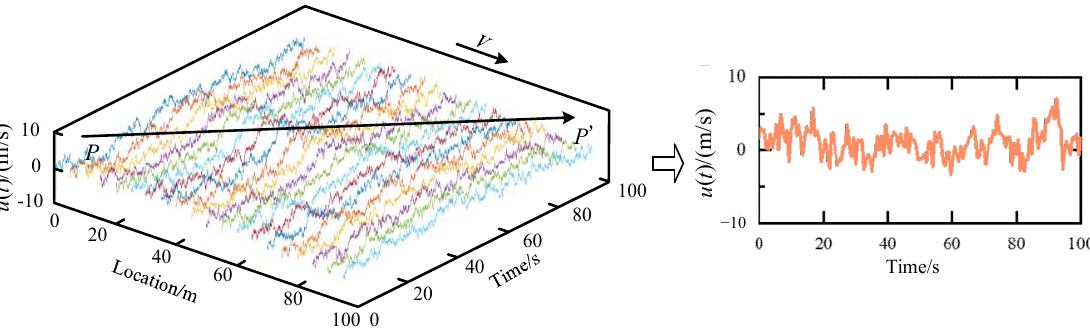
Figure 15. Scheme of the fluctuating wind velocity relative to a moving train extracting from the discrete points.